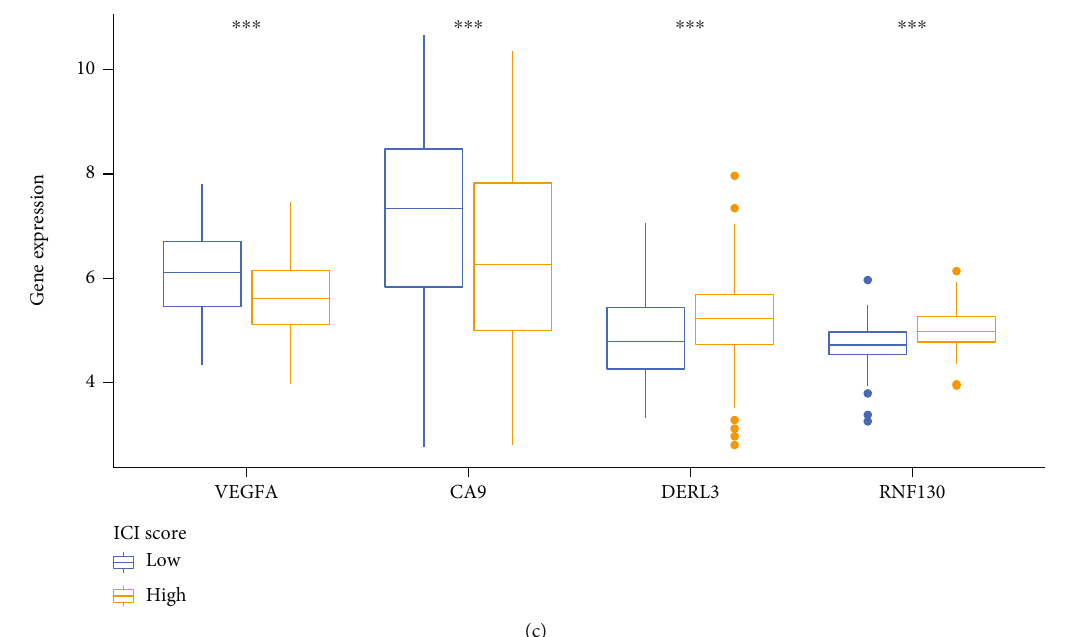
Figure 7: Consistent clustering analysis of C1 and C2 subtype di ff erential genes. (a) Clustering results of di ff erential genes between the two subtypes. (b) K-M survival curve of high and low PCA score groups of di ff erential genes. (c) Di ff erential expression box plots of the four modeled genes in the high and low PCA scoring groups. ∗ P < 0 : 05 ; ∗∗ P < 0 : 01 ; ∗∗∗ P < 0 : 001